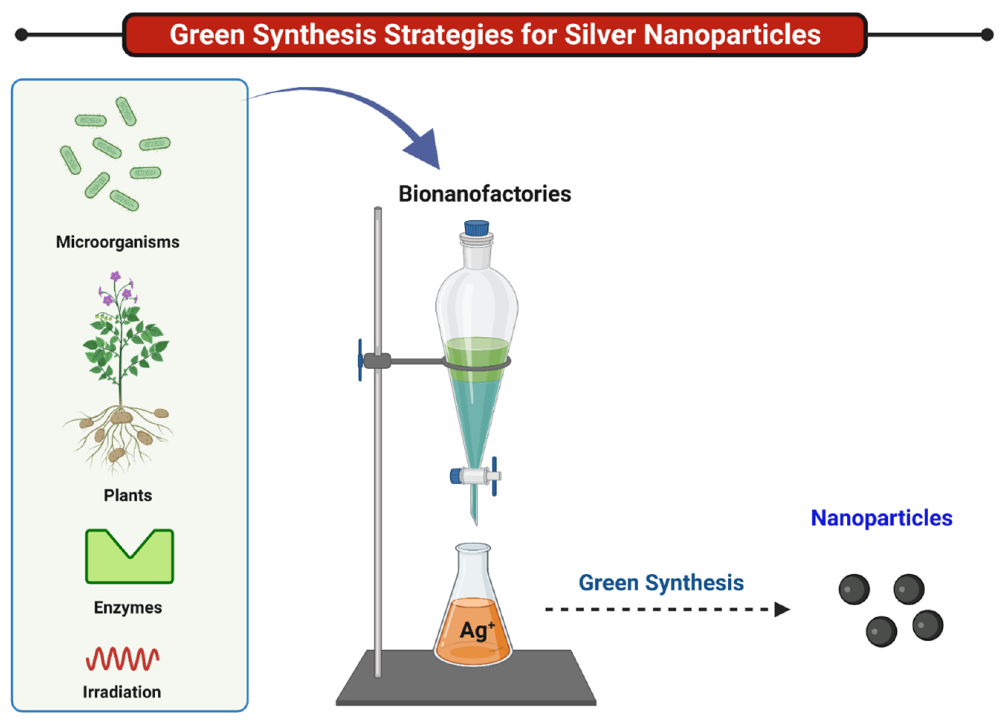
Figure 2. Green synthesis of nanoparticles of silver nanoparticles.